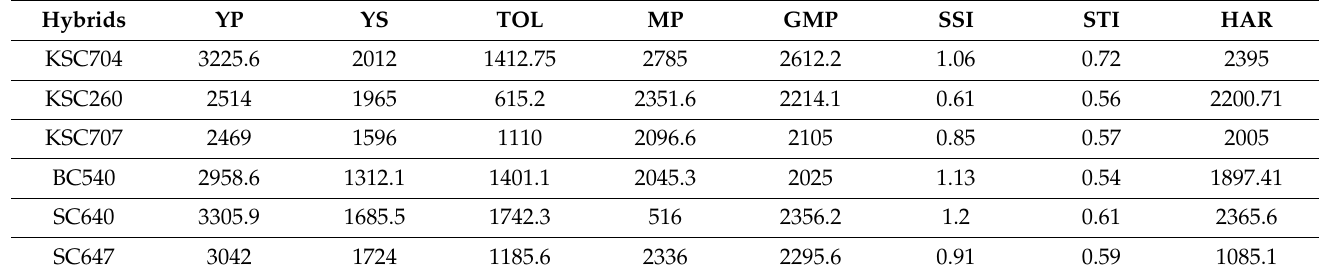
Table 3. Values of water-stress-tolerance indices on maize in the flowering